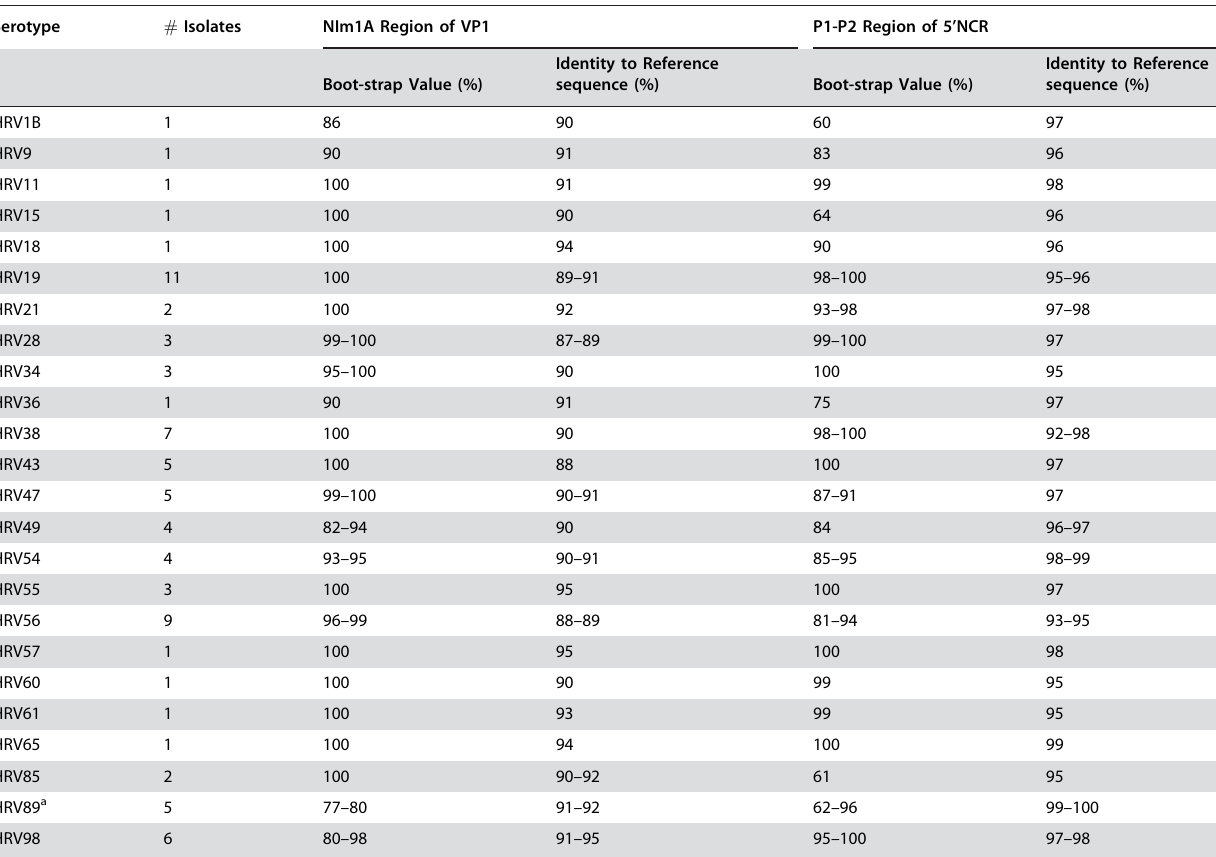
Table 1. Identification of culturable HRV clinical isolates by phylogenetic tree reconstruction. .. ... .... ... ... .... ... ... .... ... ... .... ... ... .... ... ... .... ... ... .... ... ... .... ... ... .... ... ... .... ... ... .... ... ... .... ... ... .... ... ... .... ... ... . Serotype # Isolates NIm1A Region of VP1 P1-P2 Region of 5’NCR Identity to Reference sequence (%)